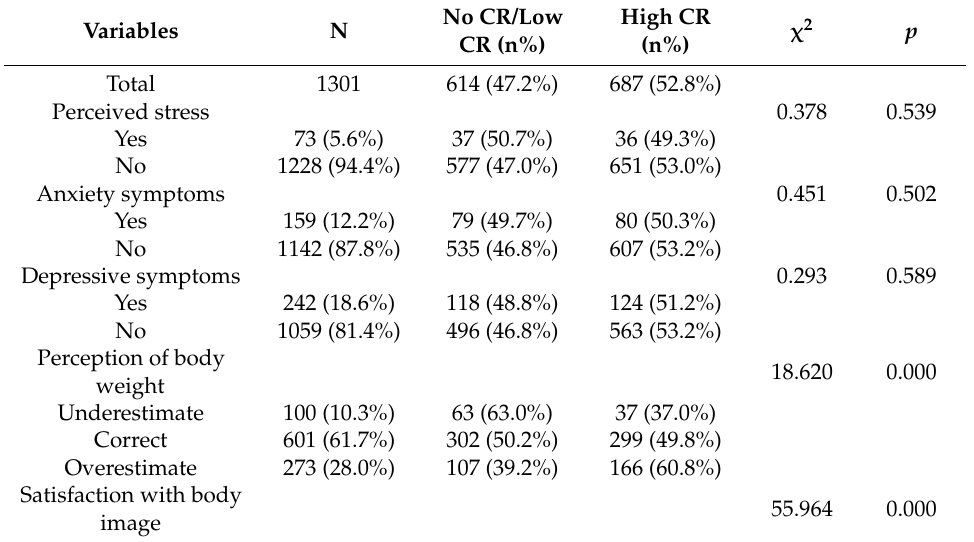
Table 3. Association between CR, emotion, perception of body weight and satisfaction with body